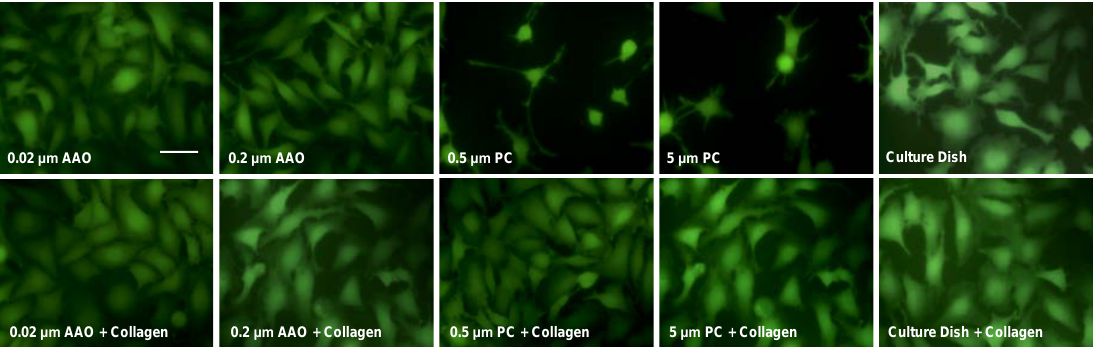
Figure 4. Podocytes incubated at 37 °C for 48 h. The images were taken by fluorescence microscopy. Scale bar, 5 μm.